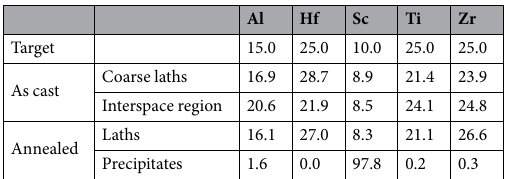
Table 3. TEM-EDS measured concentrations (at.%) of the as cast alloy in the two regions indicated in Fig. 5b by the red squares, corresponding to a region inside the coarse laths (label 1) and to the interspace region between the (coarse and fine) laths (label 2) as well as for the annealed sample shown in Fig. 7a corresponding to a lath (label 3) and precipitate (label